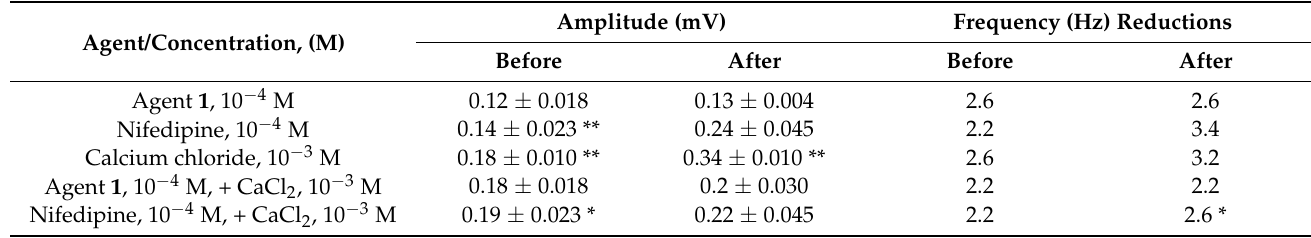
Table 12. Data on changes in contraction amplitude and